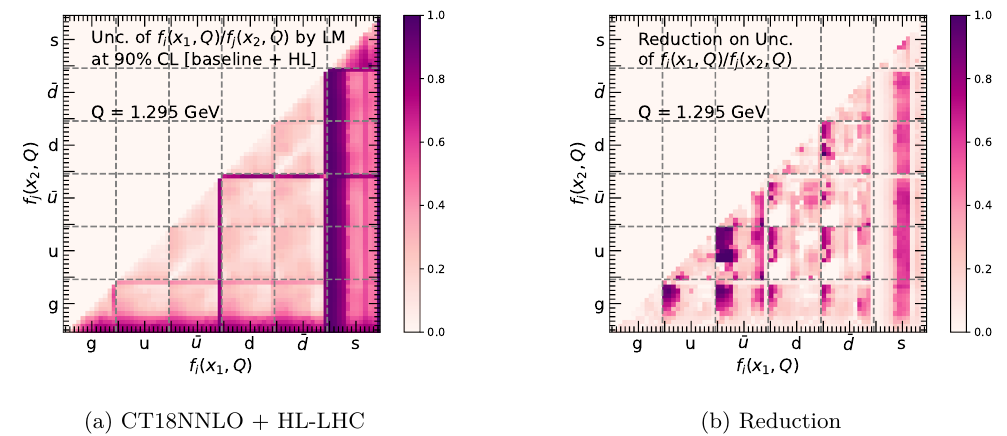
Figure 21 . The relative uncertainties of R f = f i ( x 1 , Q ) /f j ( x 2 , Q ) determined with the LM method at 90% CL are shown in panel (a), where Q = 1 . 295 GeV. In panel (b) we show the reduction factors on the relative uncertainties of R between with and without HL-LHC f